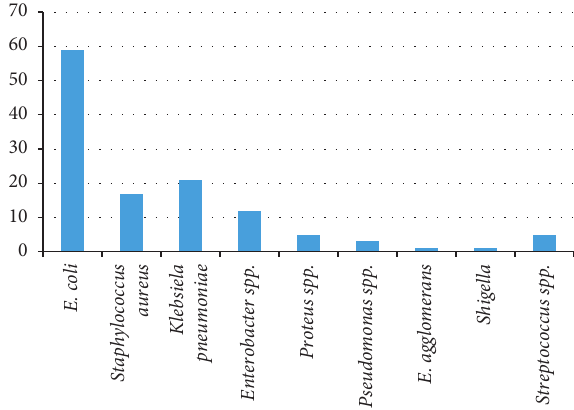
Figure 1: Prevalence of microorganism isolates.